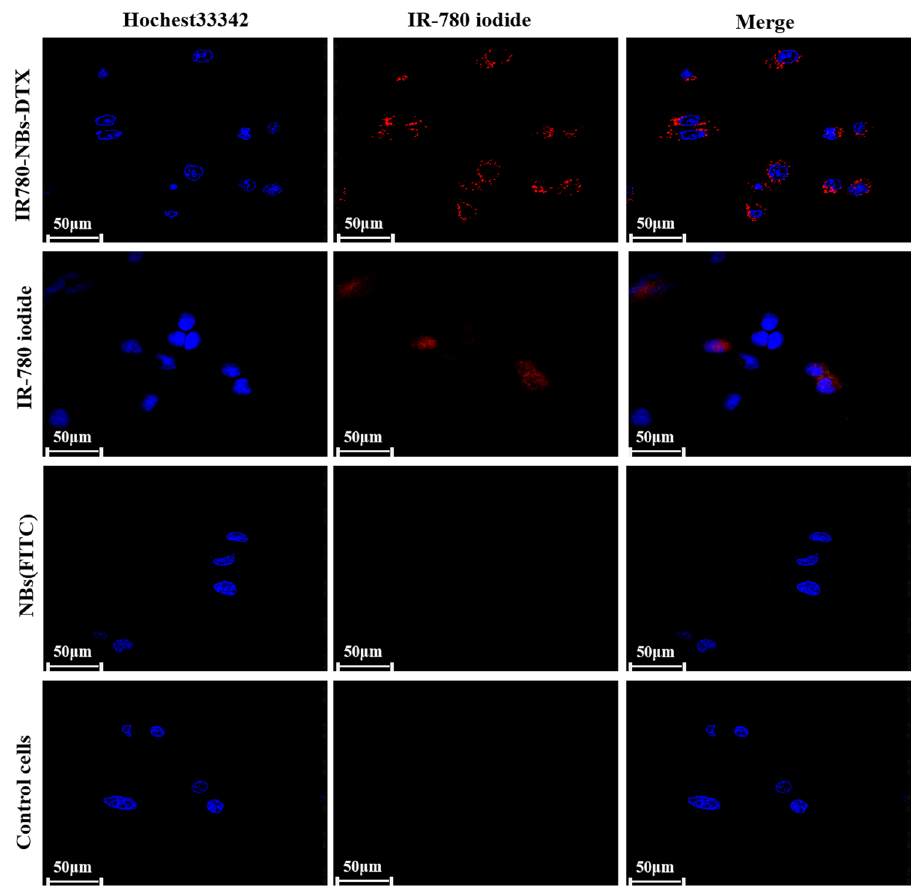
Figure 6. Tumor-targeting capability of IR780-NBs-DTX, IR-780 iodide and NBs(FITC) assessed via CLSM after incubation with Mia-Paca2 pancreatic cancer cells in